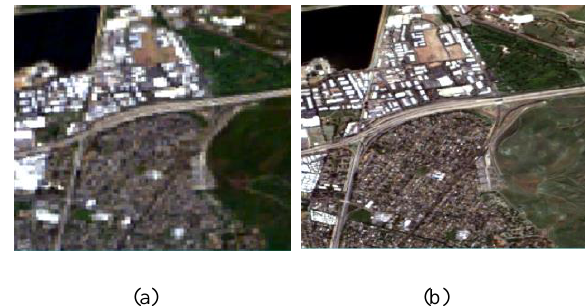
Figure 4. (a) Color composition of Hyperion image, (b) Pan- sharped